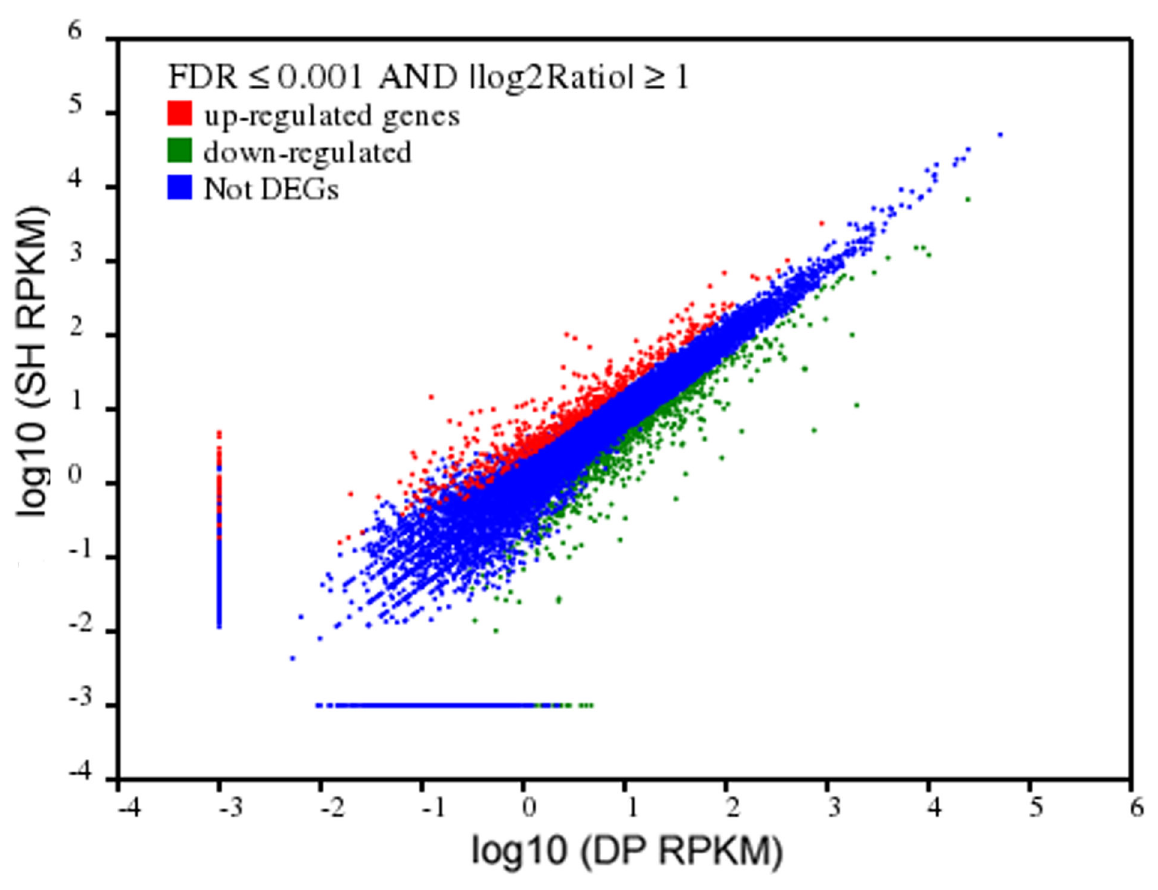
Figure 5. Comparison of gene expression levels between the two libraries. The X and Y-axes show the mRNA expression levels in the two samples. The up-regulated and down-regulated genes are shown in red and green, respectively. Blue dots represent genes with similar expression